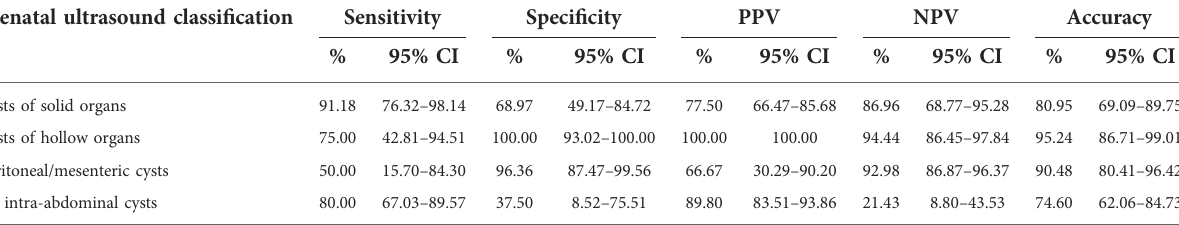
TABLE 2 Diagnostic accuracy of prenatal ultrasound records in 63 cases of intra-abdominal cysts with surgical intervention. Prenatal ultrasound classi fi